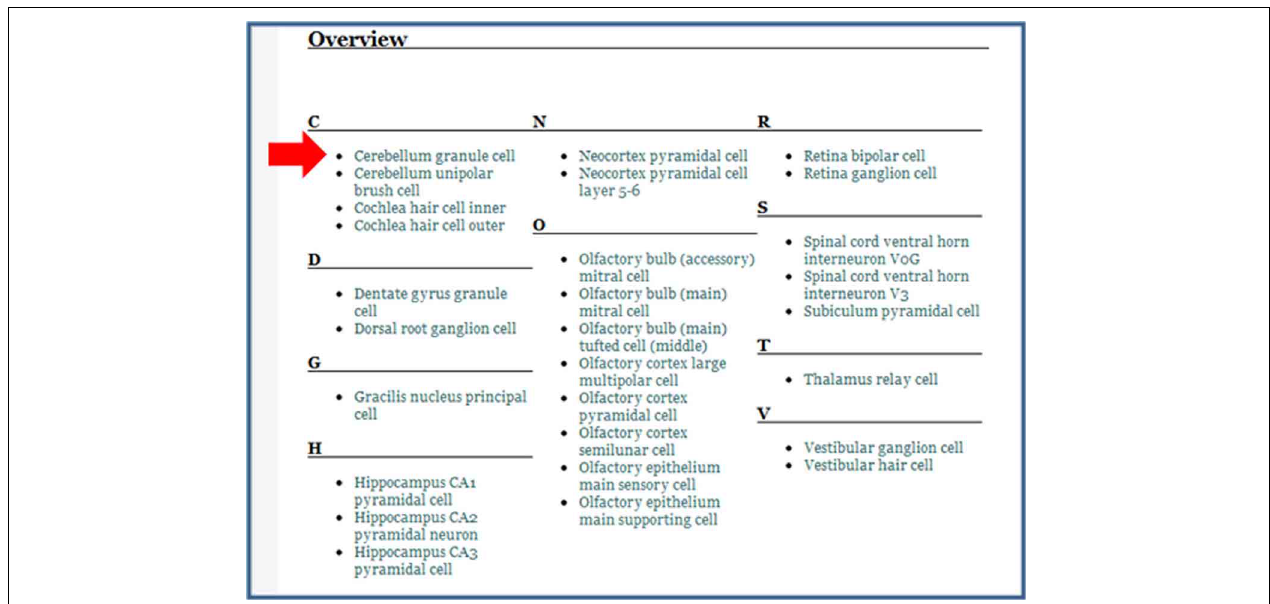
FIGURE 8 | The modified overview section of the Glutamatergic neuron page. After having entered Glutamate as the Neurotransmitter released in the Cerebellum granule cell page ( Figure 3 ), this neuron now appears in the list when it did not before (compare with open arrowhead in Figure 7 above).